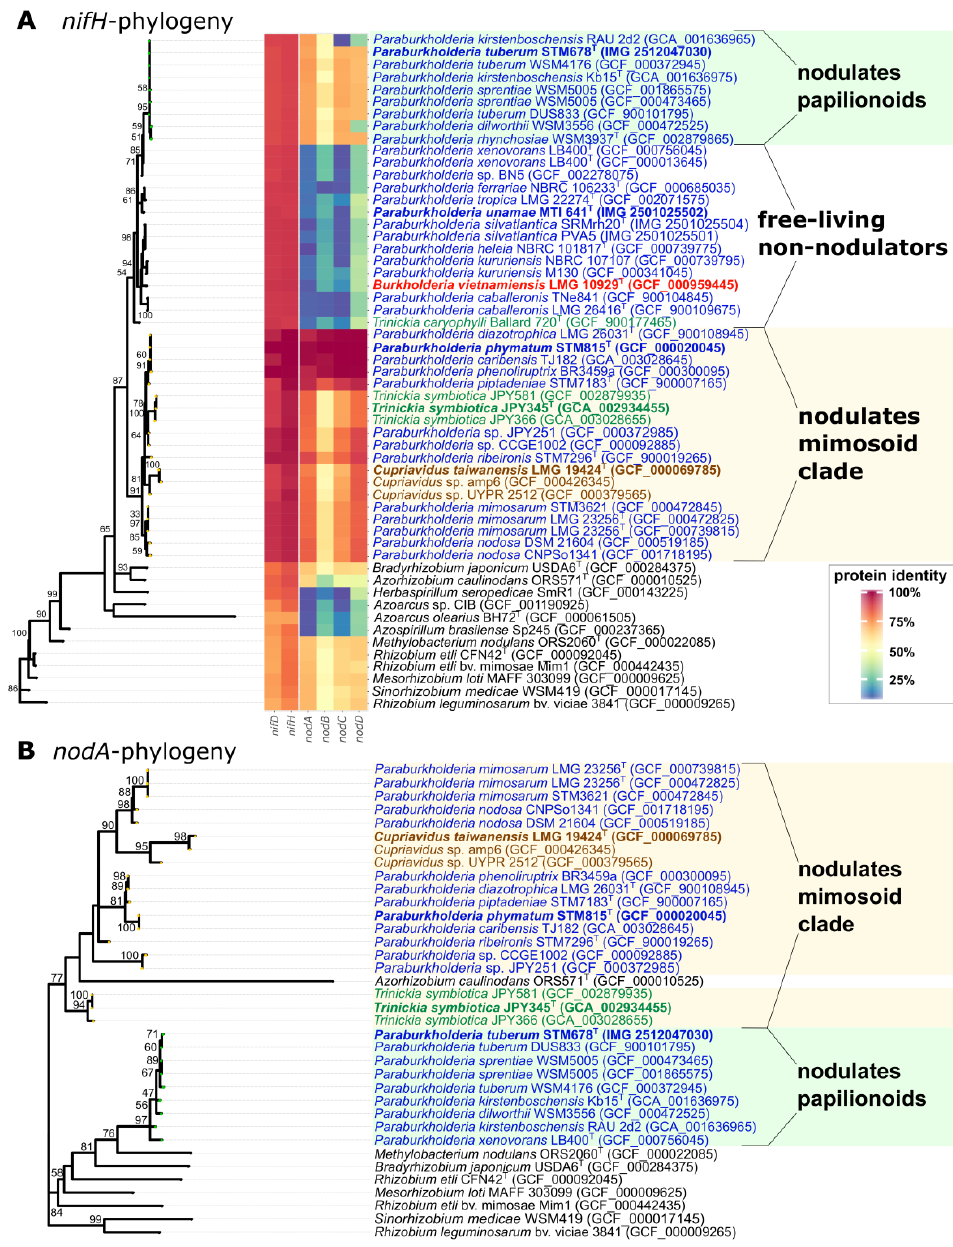
Figure 3. The ML phylogenies of Burkholderiaceae species using sequences of nifH ( A ) and nodA genes ( B ) inferred with iqTREE and using 100 nonparametric bootstrap calculations. Only bootstrap values greater than 50 are shown. α-Proteobacteria are labeled in black, Paraburkholderia in blue, Burkholderia in magenta, Cupriavidus in brown and Trinickia in green. In the nifH phylogram, non-nodulating species of bacteria harboring nitrogen-fixing genes, but no nodulation genes, are labeled as free-living non-nodulators (this group is absent in the nod -gene phylogeny). In both phylograms, the group of bacteria specifically nodulating papilionoid legumes is indicated with green shading, and the group specifically nodulating mimosoids is indicated with yellow shading; note that both the nifH and nodA gene phylogenies reveal similar grouping of nodulating strains in accordance with their indicated host specificity. Colors in the heatmap correspond to the percent identity of protein sequences to the nif and nod genes of Paraburkholderia phymatum STM815 T , which was used as the reference genome; color gradient from blue (0%) to green (25%), yellow (50%), orange (75%) and red